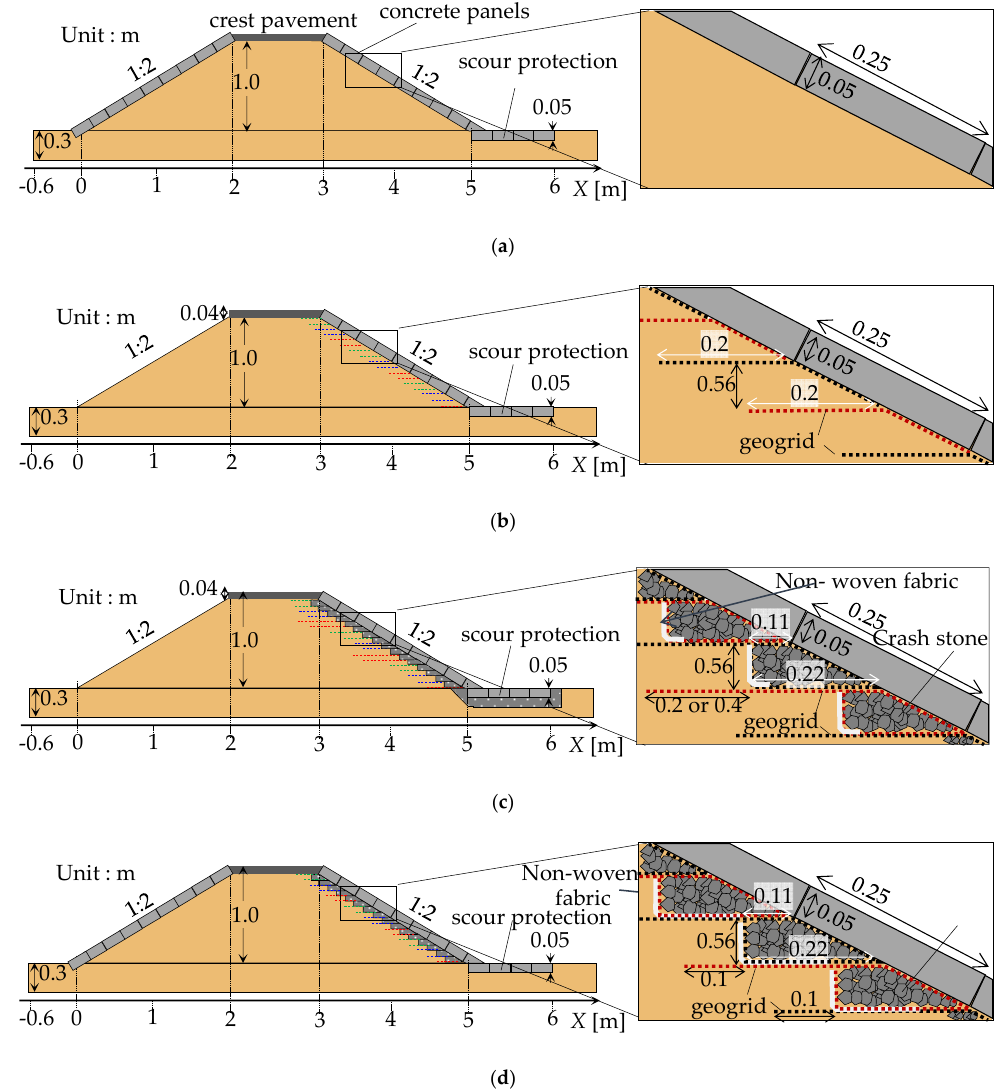
Figure 4. Reinforcement conditions for model levees: ( a ) Case A (armored levee); ( b ) Case B (GRS levee); ( c ) Case C (LDR levee with L = 20 cm); ( d ) Case D (LDR levee with L = 10 cm).